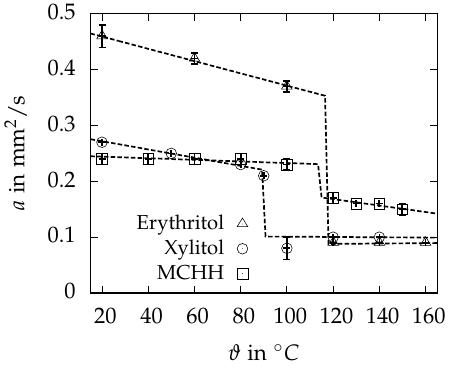
Figure 7: Enthalpy h as a function of the temperature ϑ for Figure 8: Thermal diffusivity a of the investigated PCM. The Figure 8. Thermal diffusivity a of the investigated PCM. The error bars are the standard deviation from MCHH. The solid line is the result of the DSC mea- error bars are the standard deviation from three dif- surement (Figure 6) and the dashed lines connect the ferent samples and five shots at each temperature. three different samples and five shots at each temperature. The dashed line represents the linear fit of resulting measuring points from the 3LC. The arrows The dashed line represents the linear fit of the points, the points, used to calculate the temperature dependency of a , and extrapolated to the melting point of indicate the direction of temperature change within used to calculate the temperature dependency of a, the PCM. the measurements. ϑ + e 2 to describe the temperature dependency of the Table 3. Factors for the linear equation a ( ϑ ) = e 1 · thermal